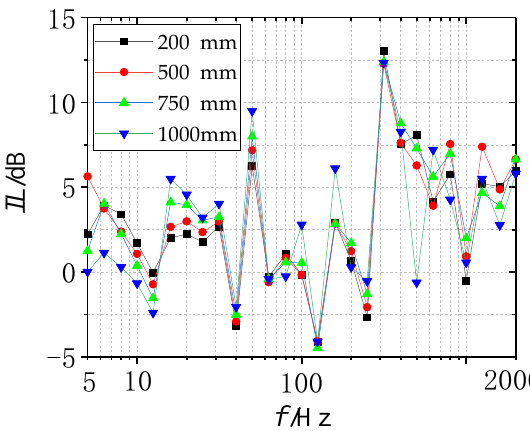
Figure 19. Insertion loss octave curves of pipeline with different coated length.